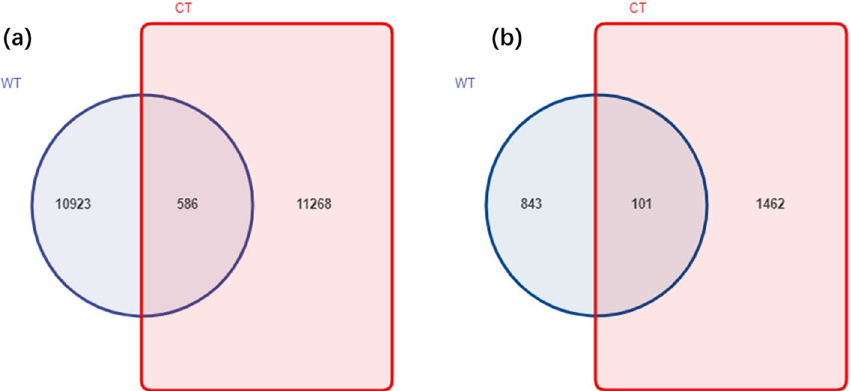
Figure 1. Venn diagram showing the number of unique OTUs of ( a ) bacteria and ( b ) fungi within O . elatus rhizosphere communities under cultivated (CT) and wild conditions (WT).